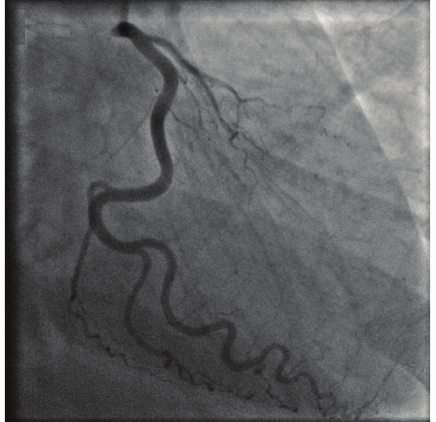
Figure 4: RAO caudal view of the left main artery giving rise to left circumflex artery, with no LAD artery visualized. Mild ostial 20– 30% obstruction of the ostial left main artery is seen. There is a small OM1/Ramus seen which does not appear to give off septal